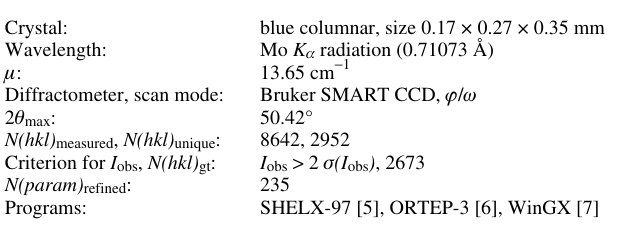
Table 1. Data collection and